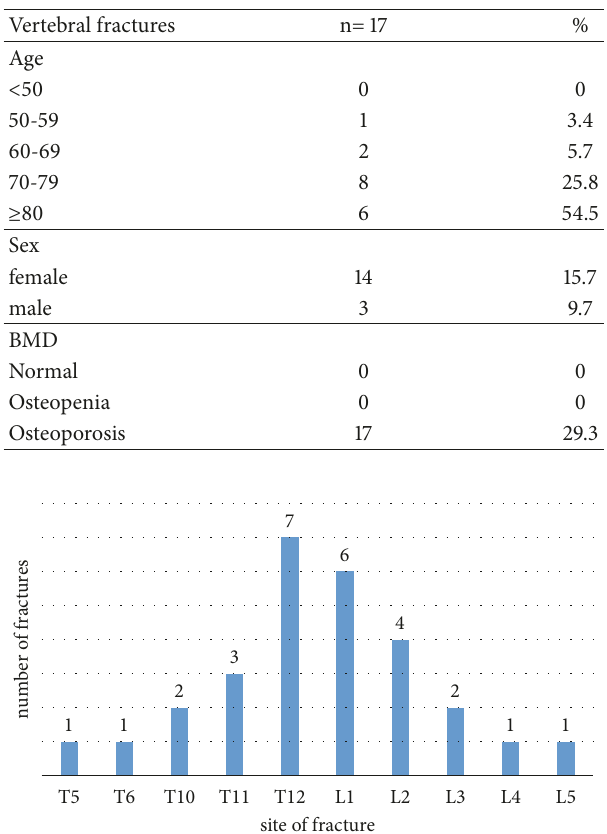
Table 3: Prevalence of vertebral fractures according to age, sex, and BMD.